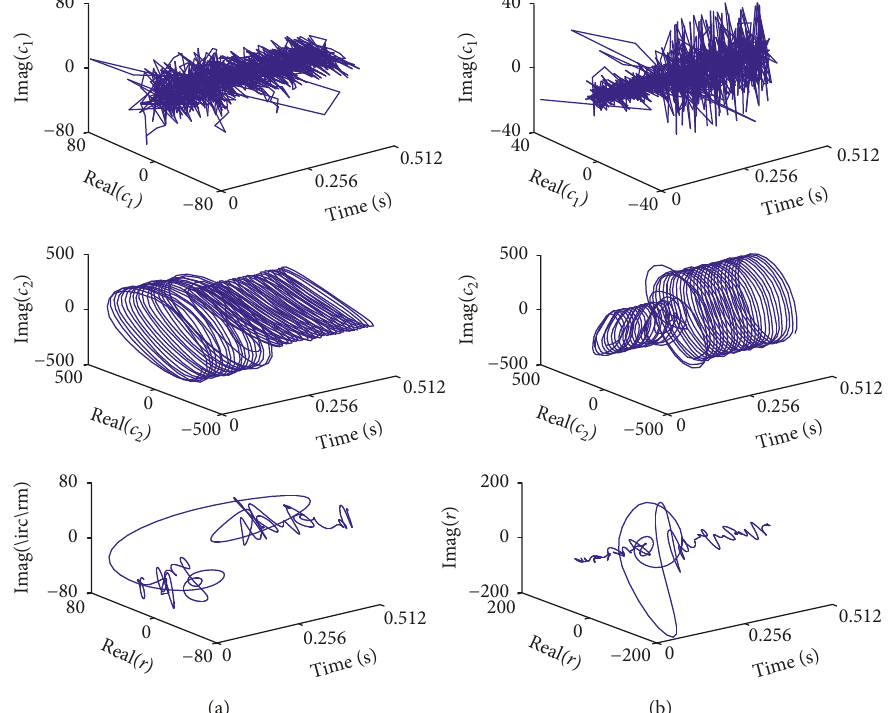
Figure 25: The decomposition results of the bistable behavior signals based on the improved BEMD